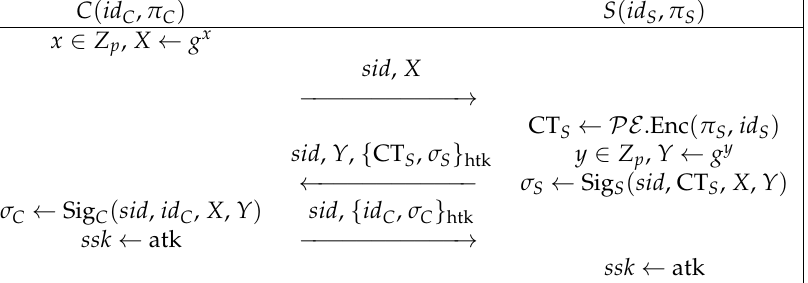
Figure 4. The private and mutual authentication protocol proposed by Wu et al. [5],